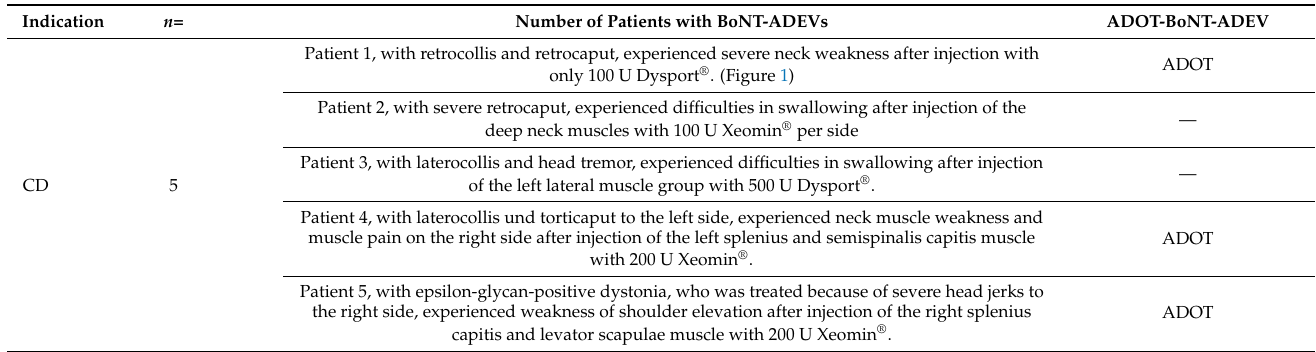
Table 2. Details of the 15